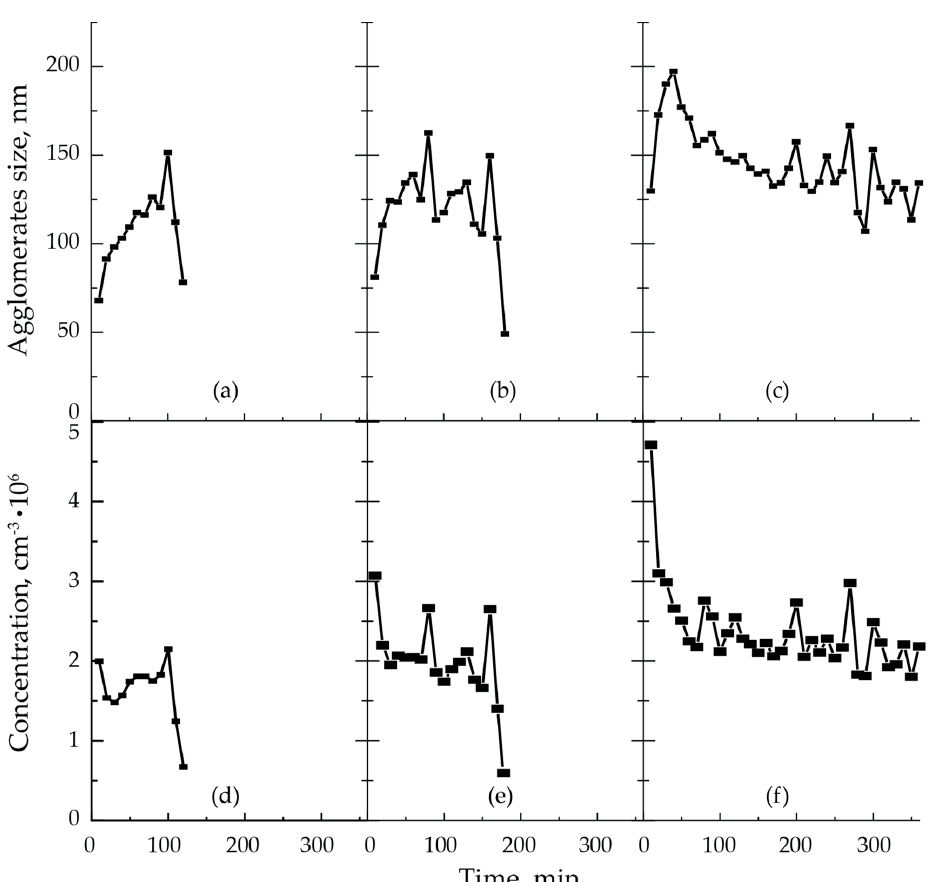
Figure 10. Time dependences of the modal size of NP agglomerates and their concentrations during the electrodes wear by the UDP for electrodes ends arranged ( a , d ) in parallel and at the angles of ( b , e ) 3 ◦ and ( c , f ) 10 ◦